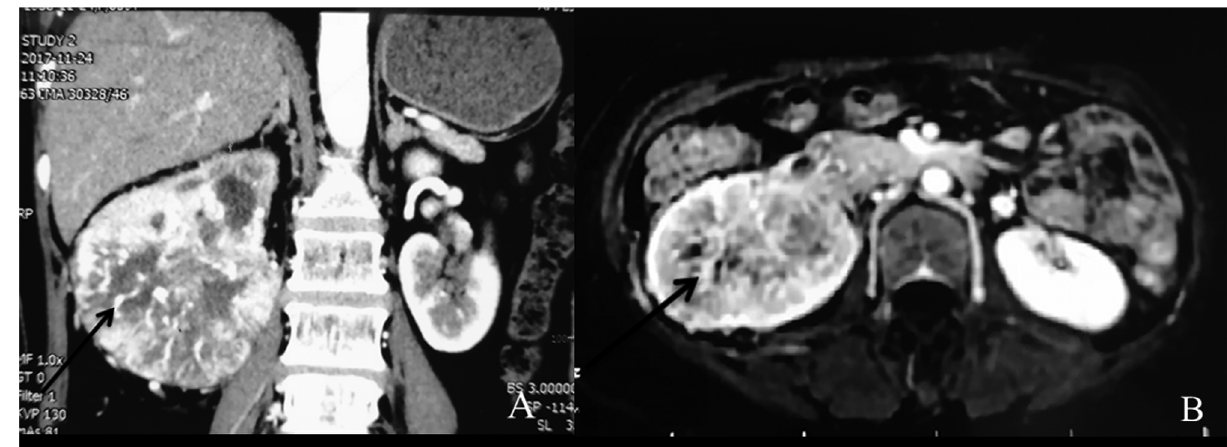
Figure 2. MRI fi ndings and an expelled worm. Axial and coronal MRI revealed that the right kidney was enlarged and severely damaged (2A and 2B)